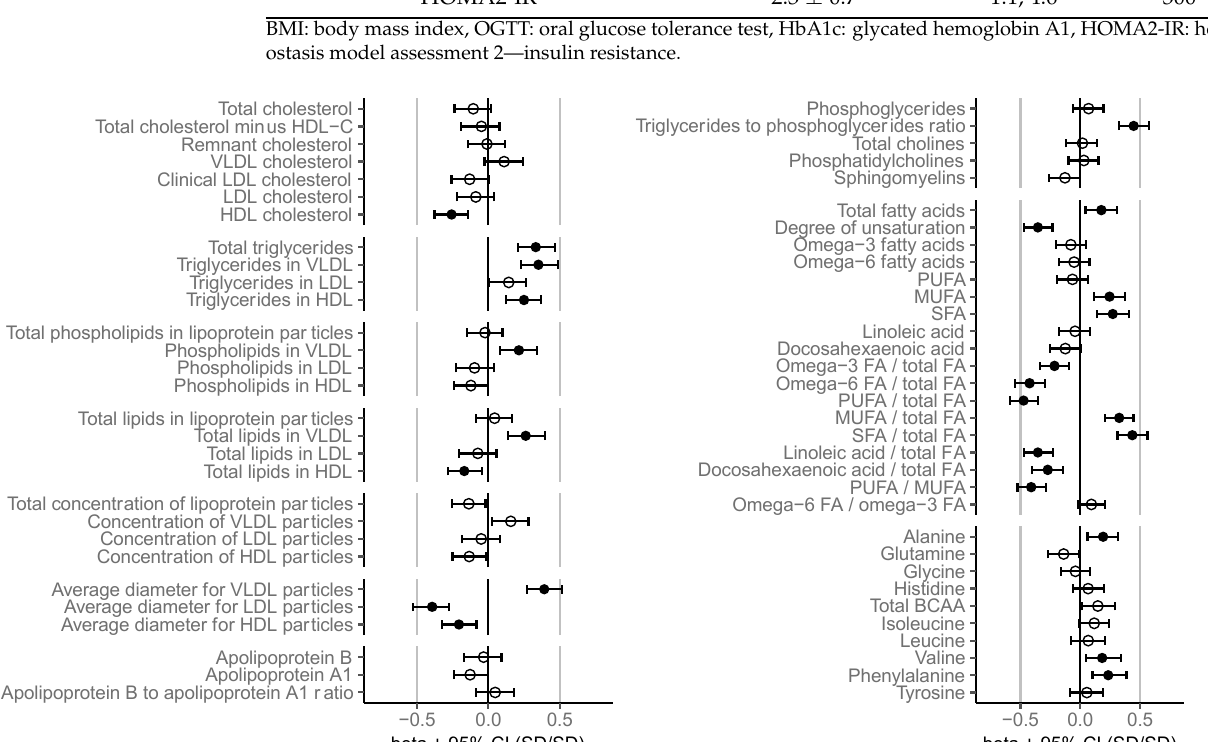
Figure 1. Associations between insulin resistance and serum metabolites. Regression β -estimates with 95% confidence intervals are given for each association adjusted for BMI class and gestational age at sampling. Filled circles denote significant ( p < 0.01) and open circles nonsignificant associations. BCAA: branched-chain amino acids, FA: fatty acids, MUFA: monounsaturated FAs, PUFA: polyunsaturated FAs, SFA: saturated FAs.